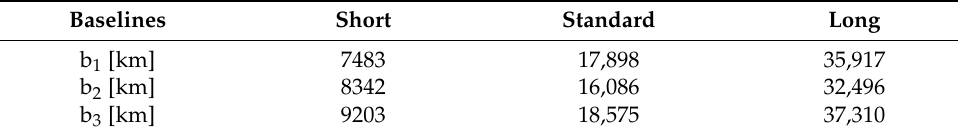
Figure 10. ESM MLAT system deployment—standard configuration in the Czech Republic. Table 1. Baselines for standard, short, and long